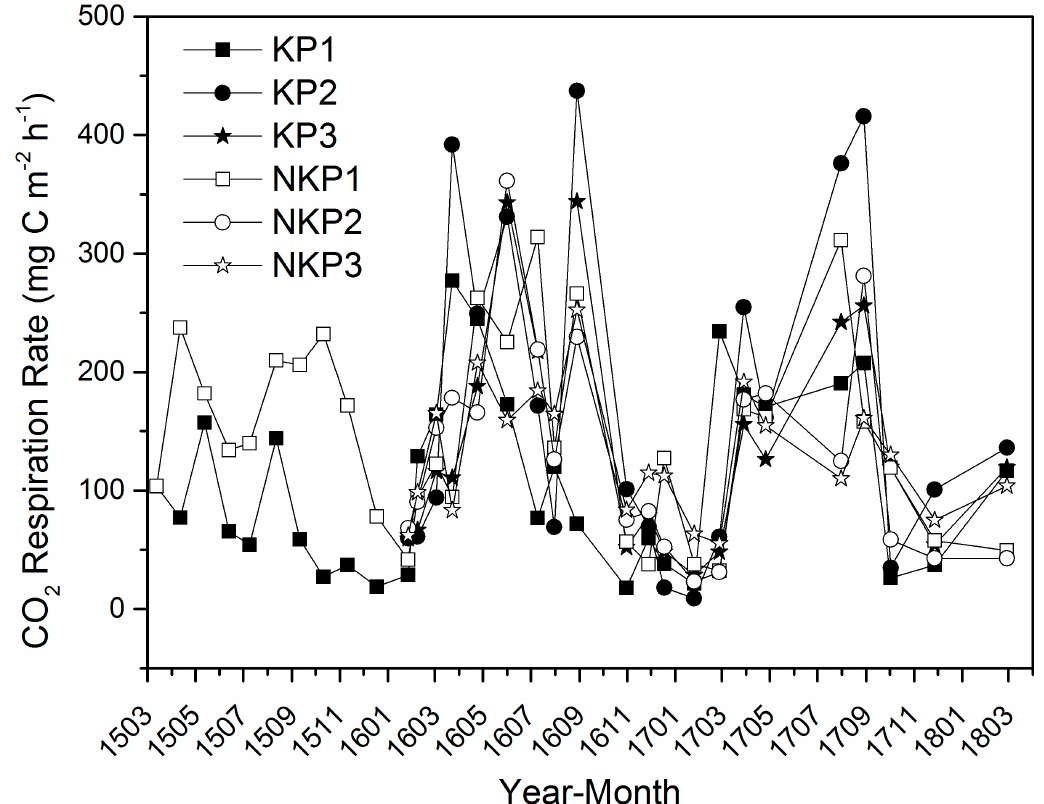
Figure 3. Respiration rates in the calcareous and red soils.